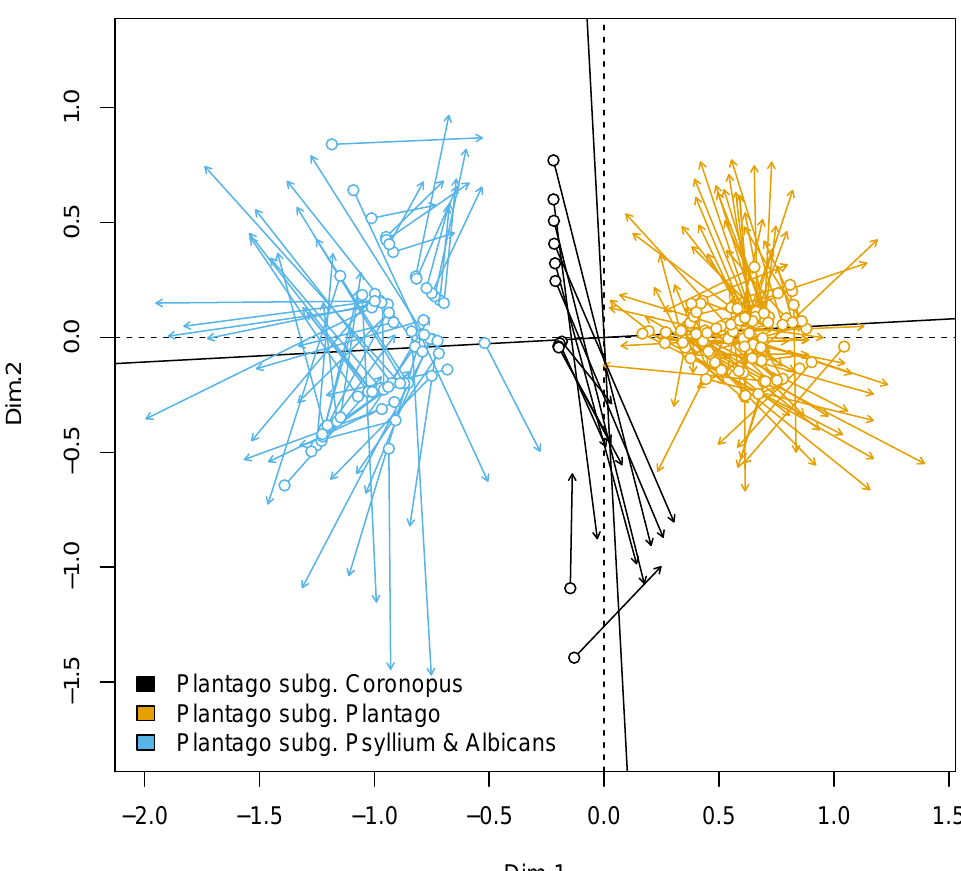
Figure 6. Scatterplot of the data points from joint molecular and morphological datasets (genus Plantago only) after the Procrustes superimposition. Differences in location of each species designated with arrows. These arrows start from the location defined by molecular data and target to the location defined by morphological data. The angle between solid and dashed axes reflects the overall Procrustean